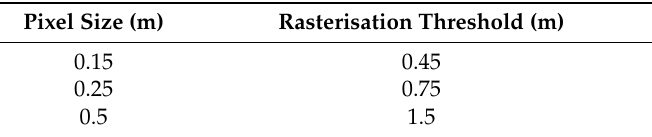
Table 2. Rasterisation thresholds for pit-free CHM generation.